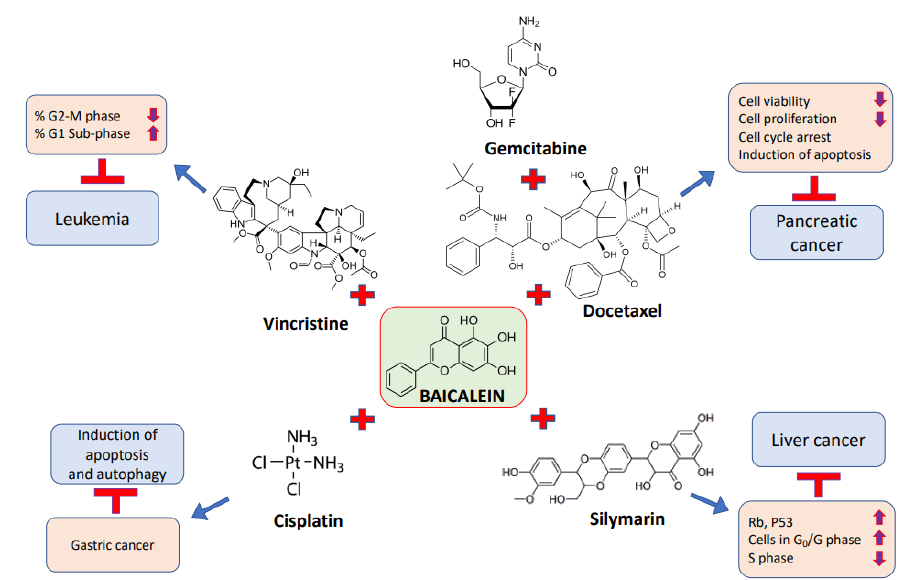
Figure 4. Synergistic effect of baicalein in cancer.